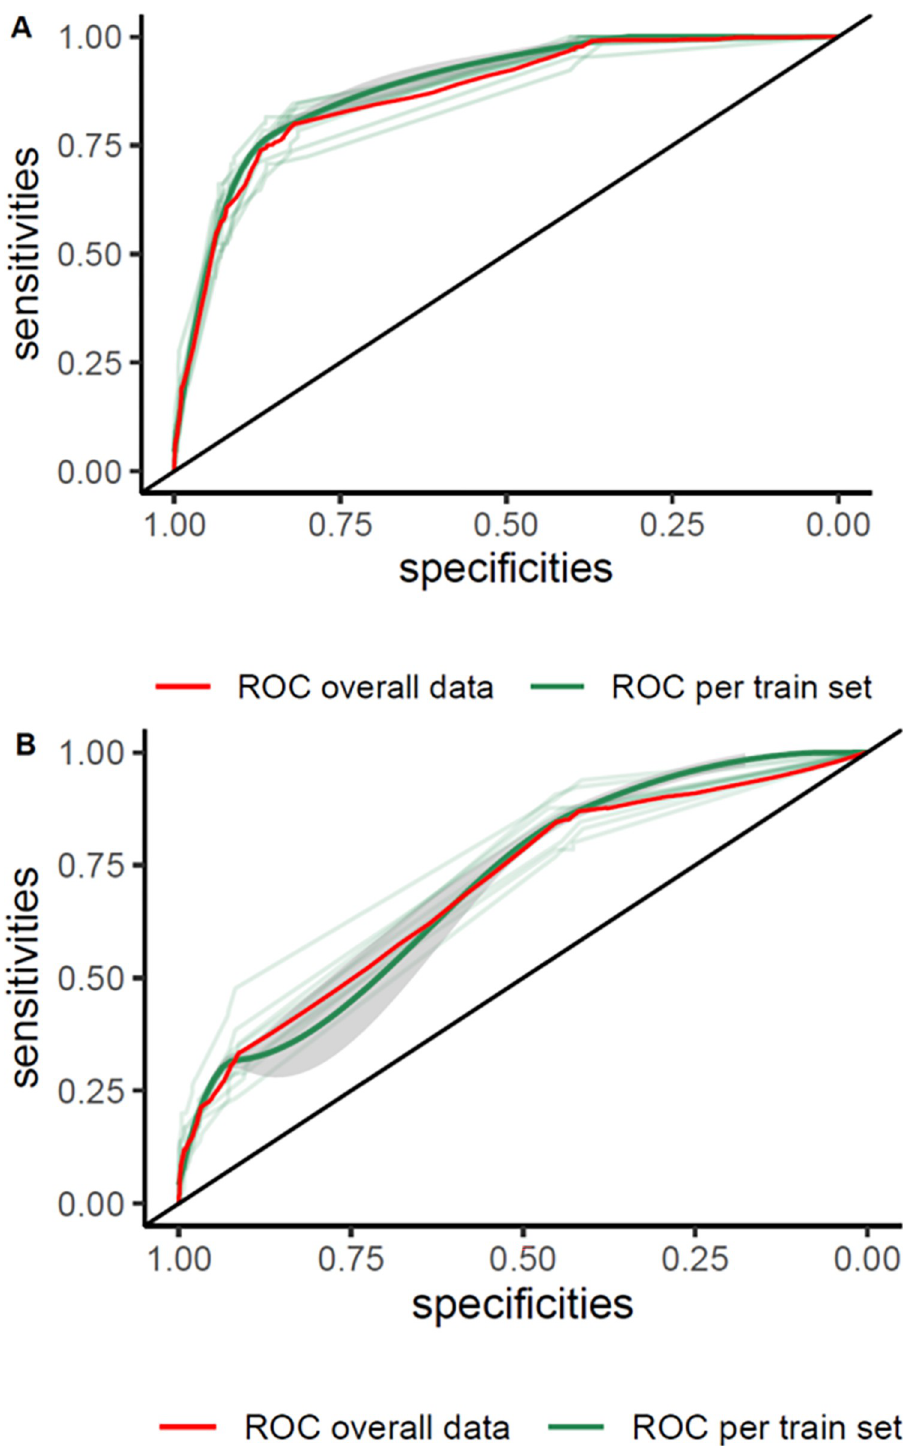
Fig 5. Receiver operating characteristic (ROC) curves for the 10-fold cross validation of both Ebola clinical prediction scores on the test set. (A) is the ROC for the extended clinical prediction score, (B) the ROC for the extended clinical prediction